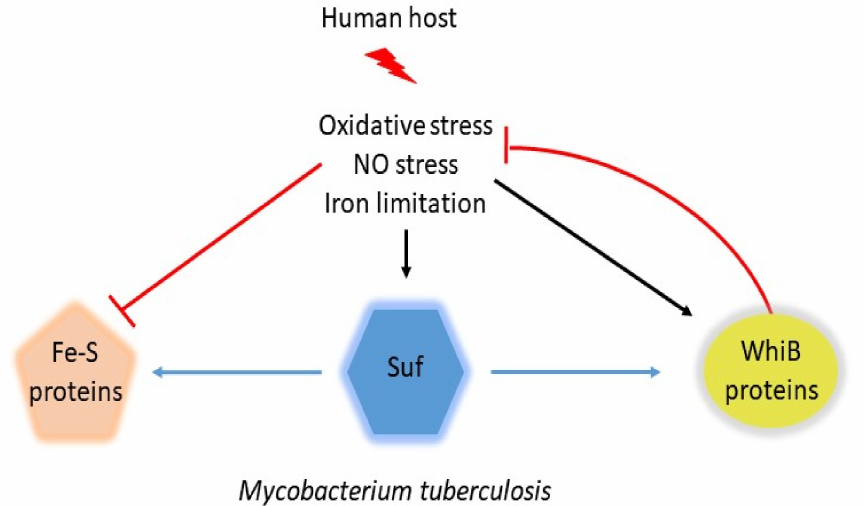
Figure 5. Importance of the SUF machinery in Mtb and its inhibition as a strategy to combat TB. The SUF system builds Fe-S clusters and transfers them to targets (Fe-S enzymes and WhiB proteins) (blue arrows). ROS and NO stresses encountered by Mtb in human host damage Fe-S clusters, inhibiting Fe-S enzymes (left red line). ROS and NO also damage Fe-S clusters of WhiB proteins that become active (black arrow) and then regulate expression of proteins to adjust Mtb metabolism to survive under stress conditions (right red line). ROS, NO and iron limitation stresses induce suf operon. Targeting the SUF system will disrupt Fe-S cluster metabolism: inability to maturate essential Fe-S enzymes and inability to detect environmental stress signals (WhiB